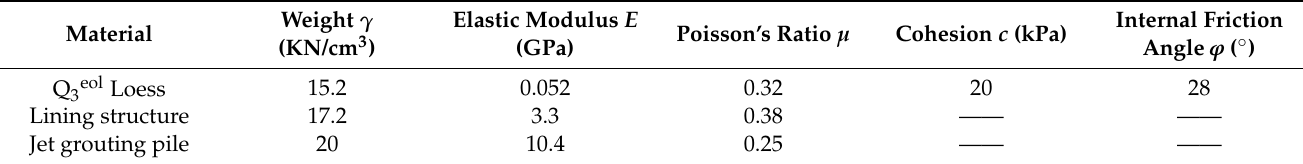
Table 3. Physical and mechanical parameters of materials.